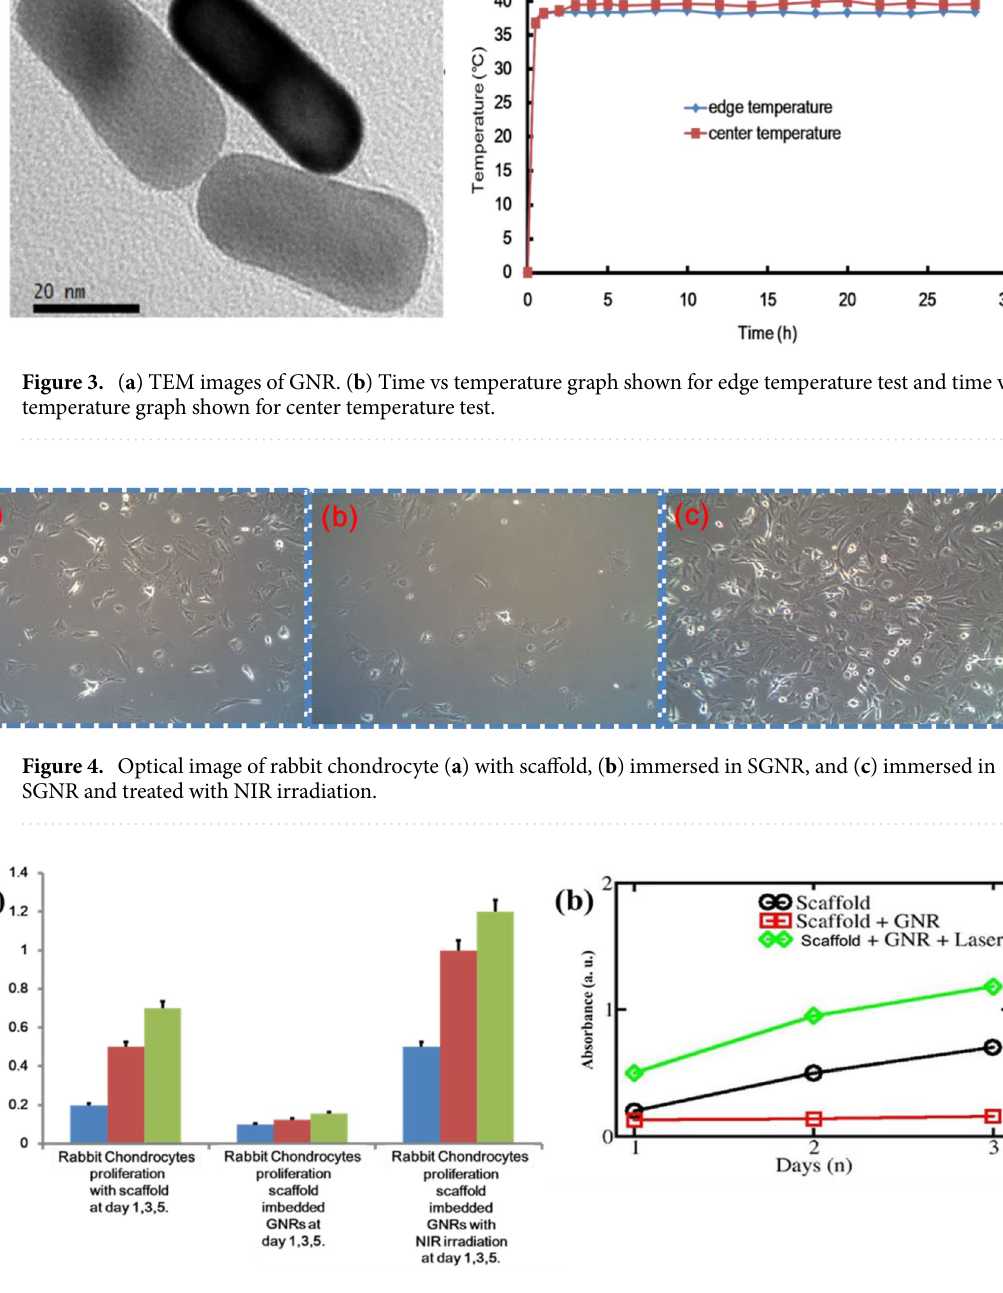
Figure 5. Above figure depicted as ( a ) Rabbit chondrocyte proliferation study with the scaffold (control). Rabbit chondrocytes proliferation study with SGNR. Rabbit chondrocyte immersed in SGNR were treated with 633 nm NIR irradiation at 180 mW for 4 h. Intensity profile ( b ) was monitored as a function of